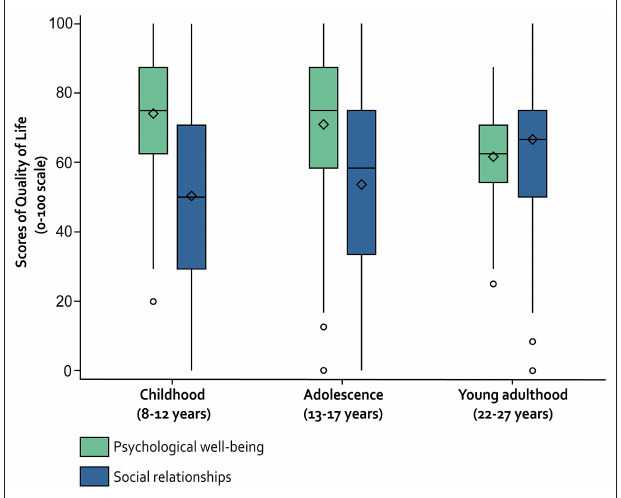
FIGURE 2 | Distribution of QoL scores of individuals with CP from childhood to young adulthood—SPARCLE cohort—France, Germany, Italy, Sweden.